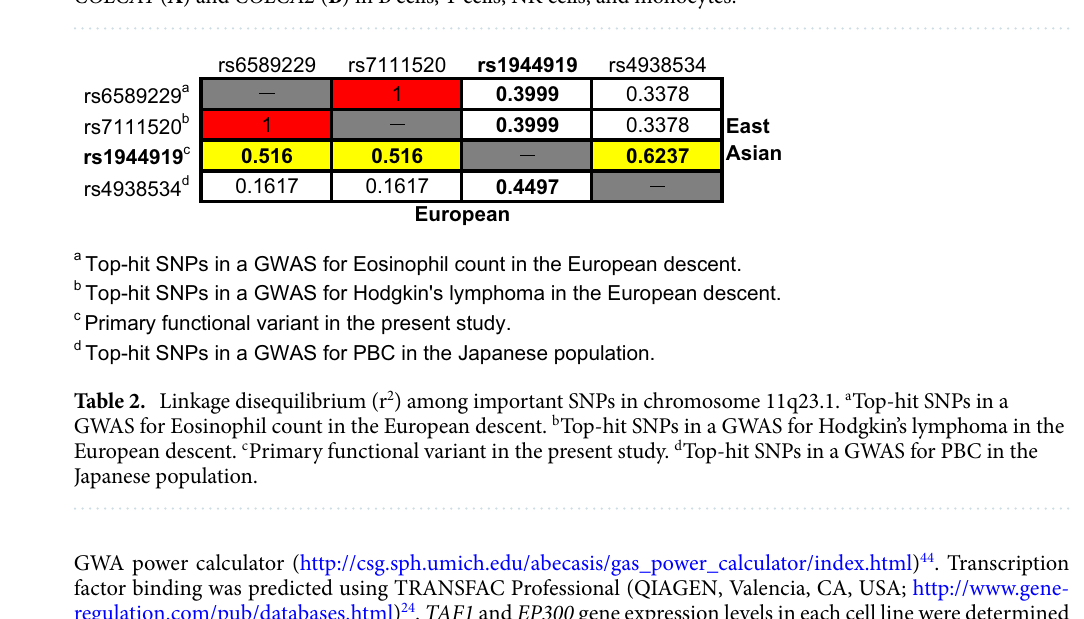
Figure 5. B cell-specific expression of COLCA1 and COLCA2 among lymphocytes. Expression levels of COLCA1 ( A ) and COLCA2 ( B ) in B cells, T cells, NK cells, and monocytes.